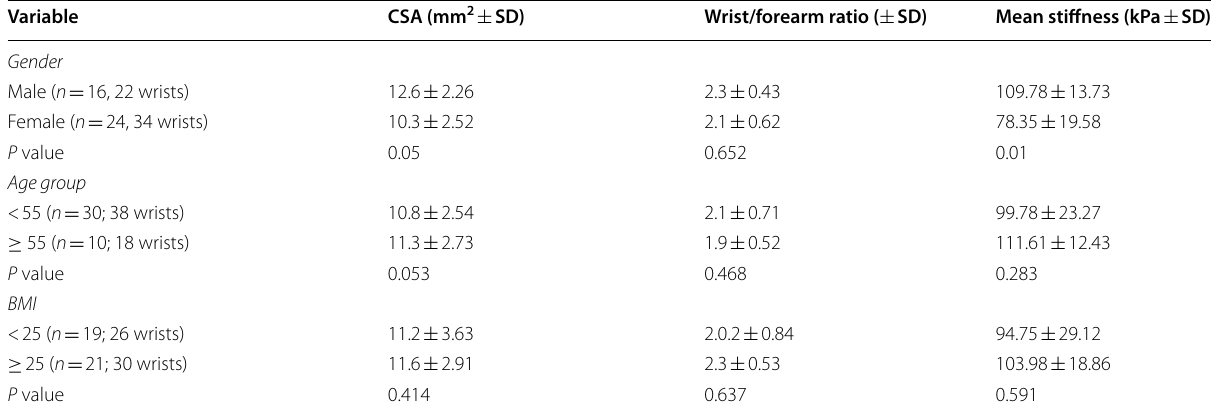
Table 4 Quantitative Analysis of CSA of median nerve, wrist/forearm ratio and mean stiffness (elasticity) between CTS patients ( n 56